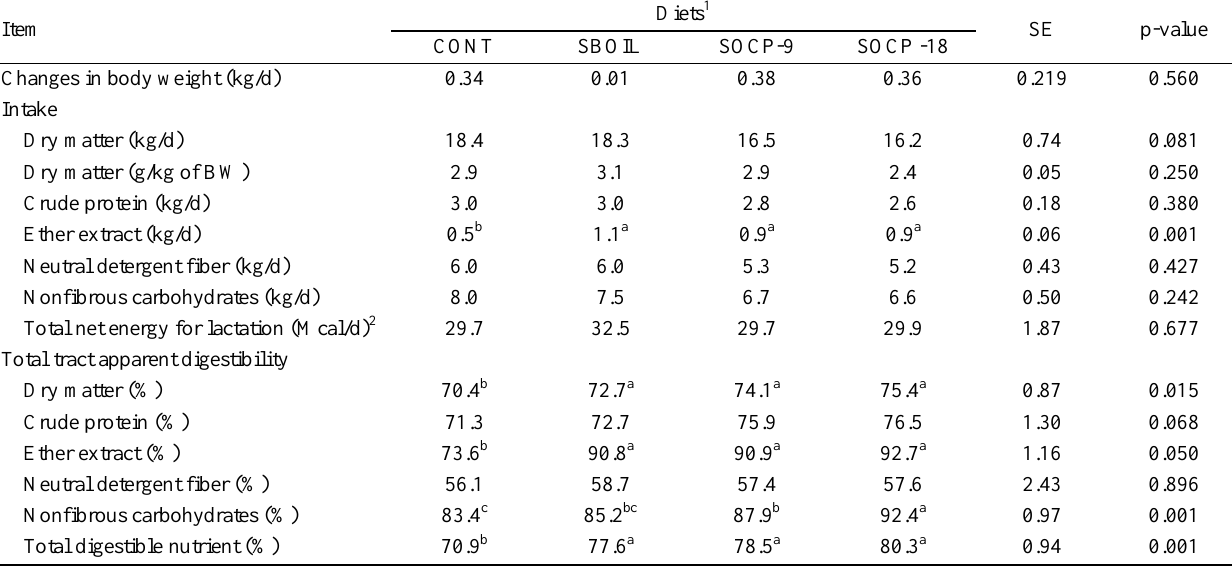
Table 3. Changes in body weight, and intake, digestibility and total digestible nutrients of diets